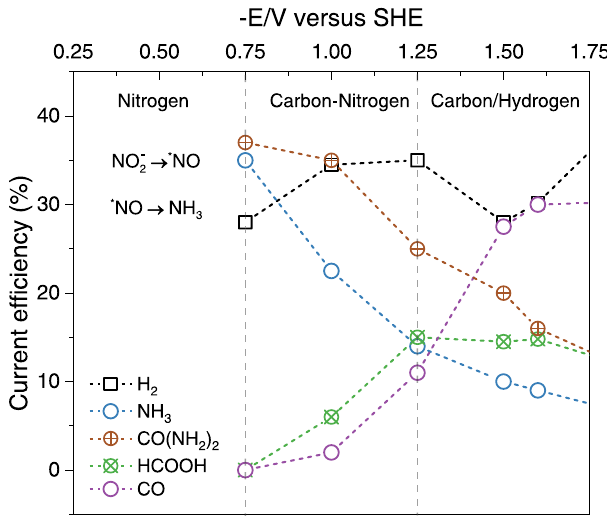
Fig. 1 | Co-electroreduction of CO 2 and NO 2 − on copper electrode. Experimen- tallydeterminedcurrentef fi ciencyforthemajorreductionproductsfromCO 2 and NO 2 – ataCuloadedgas-diffusionelectrodeasafunctionoftheelectrodepotential, reproduced with permission from the Shibata et al 19 . article. Copyright 1998,